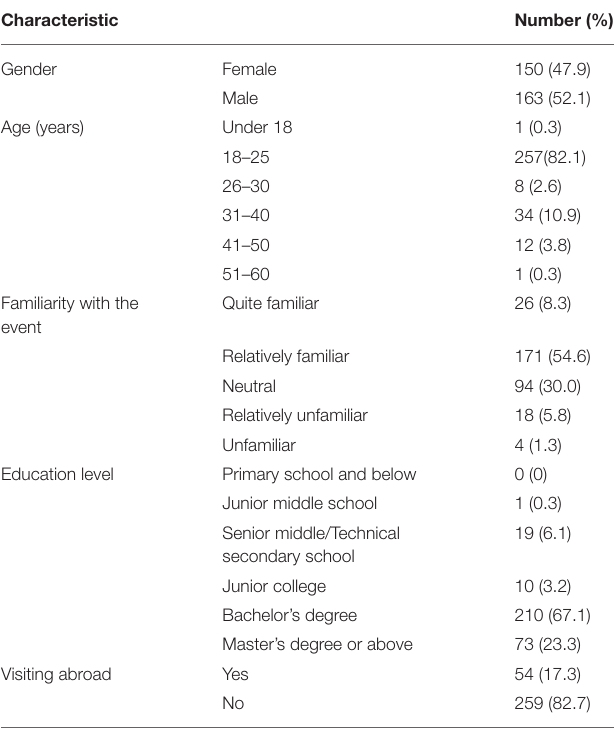
TABLE 1 | Descriptive statistics of participants’